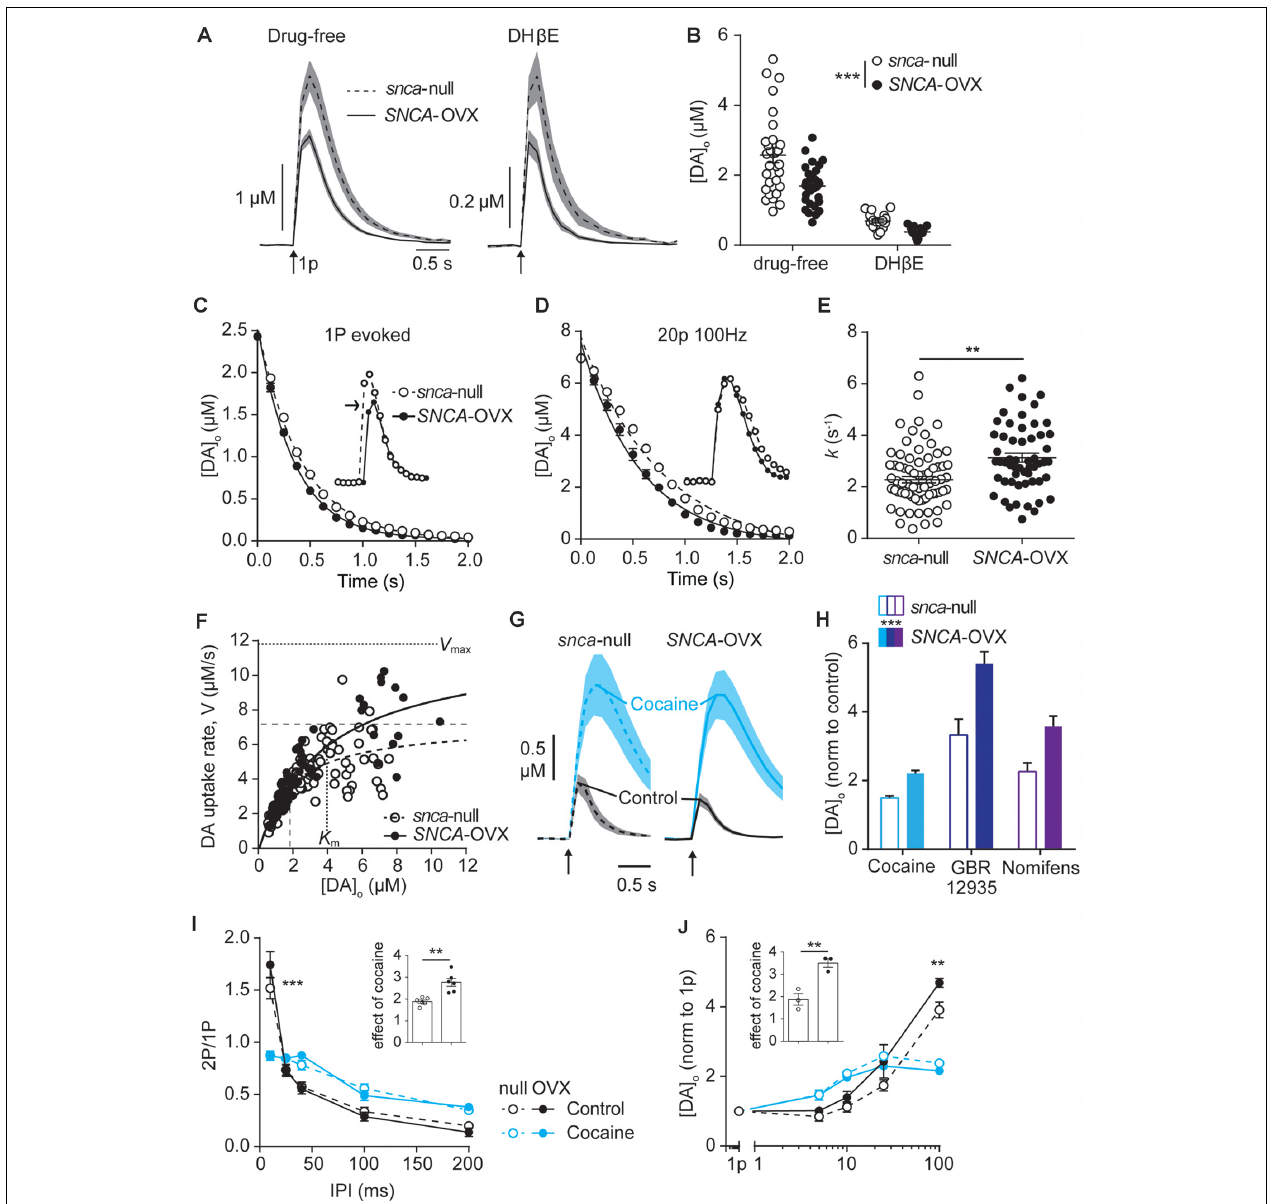
FIGURE 1 | Dopamine transporters (DAT) function is potentiated by α -synuclein. (A) Mean [DA] o ± SEM ( shaded ) evoked by single pulses ( arrow ) vs. time in caudate putamen (CPu) of Snca -null (dashed line) and SNCA -OVX (solid line) mice in drug-free conditions ( left ) or DH β E ( right ). (B) Summary of peak evoked [DA] o . *** P < 0.001, two-way ANOVA main effect of genotype: F (1,90) = 14.54, P = 0.0003; drug x genotype interaction: F (1,90) = 3.19, P = 0.078. (C,D) One-phase exponential decay curve fits for falling phases of the mean of concentration-matched [DA] o transients evoked by a single pulse (C) or 20p 20 Hz in the presence of DHBE (1 µ M), 4-aminopyridine (100 µ M), L-741,626 (1 µ M) (D) , for Snca -null and SNCA -OVX mice. Insets , transients offset to allow for concentration-matching (arrow) . Comparison of k , Snca -null vs. SNCA -OVX: 1p, 2.39 vs. 2.92, F (1,825) = 64.5, P < 0.0001; 20p, 1.29 vs. 1.73, F ( 1,842 ) = 53.01, P < 0.0001. (E) Summary of k (s − 1 ) calculated for all transients, 2.34 vs. 3.13, t (123) = 3.35, ** P = 0.0011. (F) Maximum decay rates seen for each transient vs. [DA] o at that rate for Snca -null (unfilled) and SNCA -OVX (filled). Unconstrained Michelis–Menten curve-fits for null ( dashed ) and SNCA -OVX (solid). V max and K m are indicated by horizontal and vertical lines. V max = 7.20 vs. 11.84 µ M/s, K m = 1.82 vs. 3.97 µ M, comparison of fits: F (2,181) = 15.75, P < 0.001, R 2 = 0.52 and 0.80. (G) Mean [DA] o ( µ M) ± SEM vs. time evoked by single pulses ( arrow ) in CPu, before cocaine (control, black line) and in the presence of cocaine (blue, 5 µ M). (H) Summary of effects of DAT inhibitors cocaine, GBR 12935 and nomifensine on 1p-evoked [DA] o in Snca -null and SNCA -OVX, two-way ANOVA: effect of drug, F (2,28) = 18.63, P < 0.0001; effect of genotype, F (1,28) = 18.67, P = 0.0002; genotype x cocaine interaction, F (2,28) = 0.91, P = 0.41. (I) Paired-pulse ratios (PPR) for [DA] o vs. inter-pulse interval (IPI) in control conditions (DH β E; black ), and with cocaine ( blue ) in Snca -null (unfilled) and SNCA -OVX (filled). Two-way ANOVA: condition x IPI interaction, F (12,100) = 137.9, P < 0.0001, Sidak’s post-test *** P < 0.001. (J) Peak [DA] o (normalized to condition 1p) ± SEM vs. frequency for 4p trains (5–100 Hz) in control (in the presence of DH β E; black ) and cocaine ( blue ) in Snca -null (unfilled) and SNCA -OVX (filled). Two-way ANOVA: condition x frequency interaction, F (12,40) = 19.56, P < 0.0001, Sidak’s posttest: *** P < 0.001. Insets, normalized effect of cocaine on 1p-evoked release for these datasets.